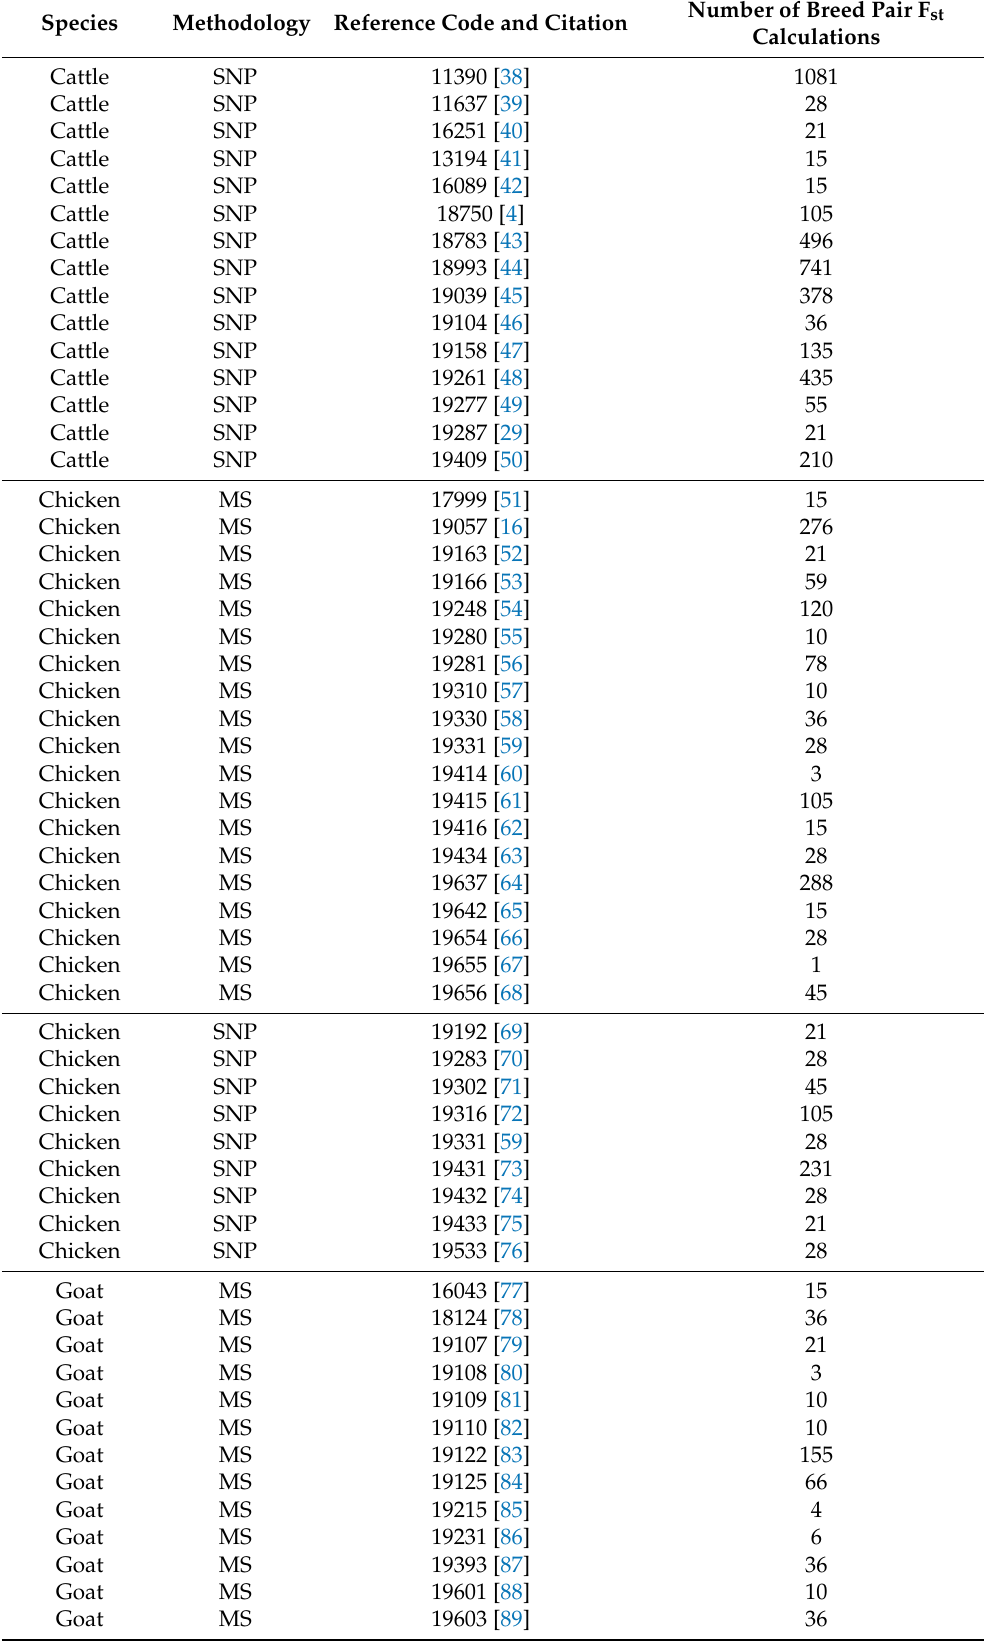
Table 1. Cont. Species Methodology Reference Code and